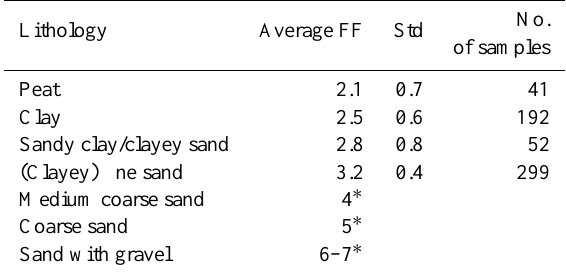
Table 1. Formation factors (FF) for different lithological